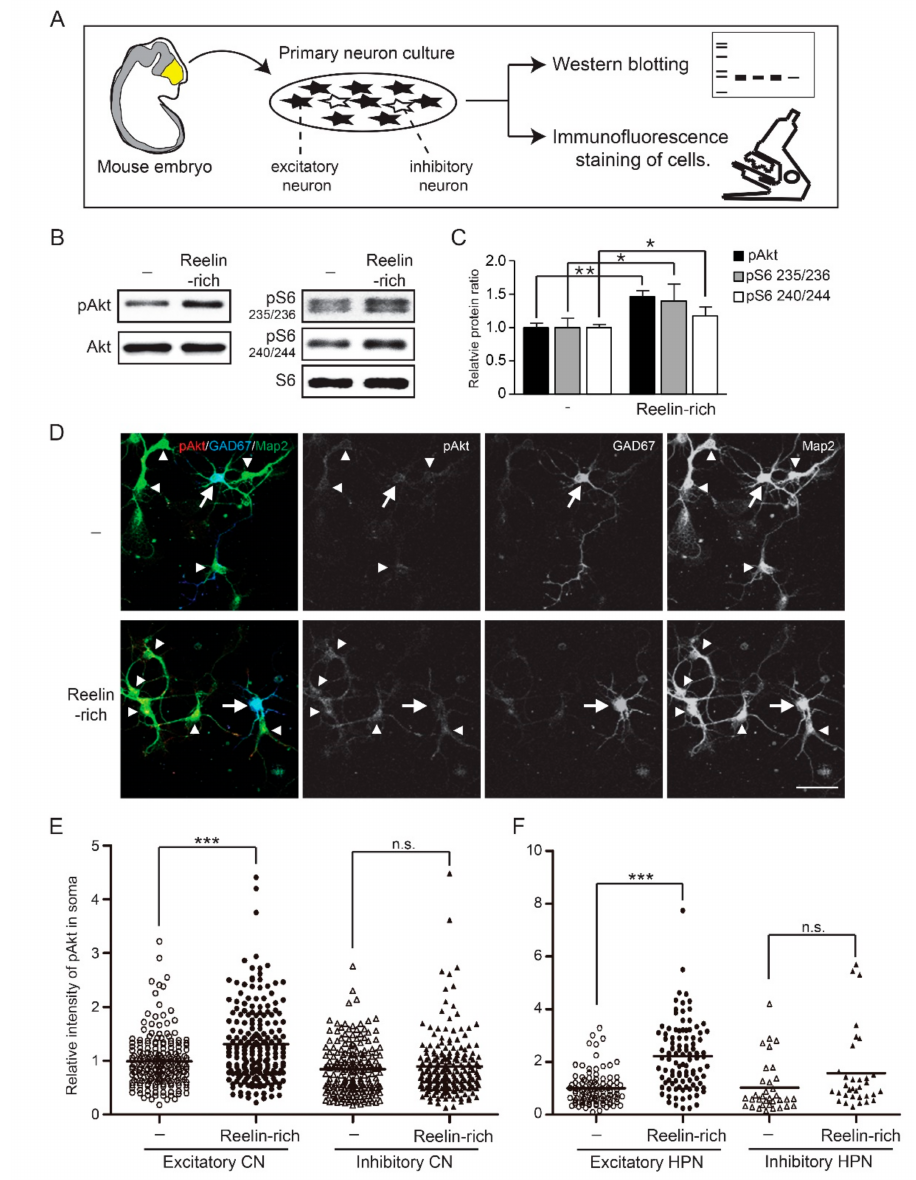
Figure 1. Phosphorylation of Akt and ribosomal S6 protein by Reelin-rich protein supplementation in individual inhibitory neurons: ( A ) Schematic diagram of the neuronal culture and methodology. Primary cortical or hippocampal neurons isolated from the brain of mouse embryos are composed of mostly excitatory neurons and some inhibitory neurons. The protein extract was used for Western blotting, regardless of the cell type, but individual neurons were visualized with a confocal